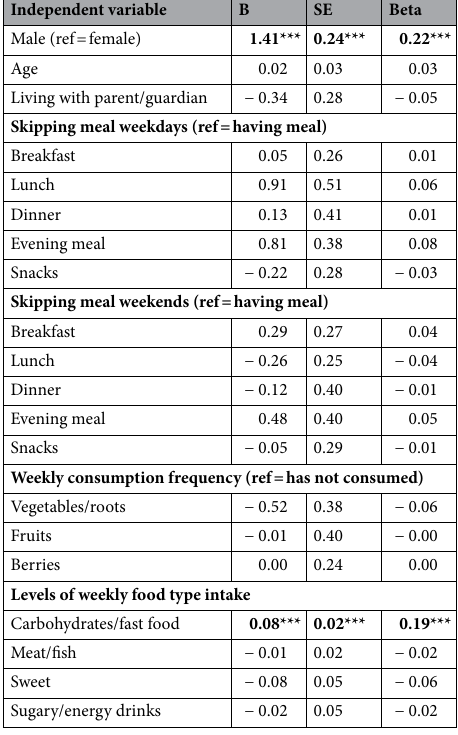
Table 5. Linear regression analysis using the enter method with levels of total IGDT scores as the dependent variable. R 2 = 0.189, Adjusted R 2 = 0.102, p = level of significance (* p < 0.05, ** p < 0.01, *** p < 0.001). Significant values are in